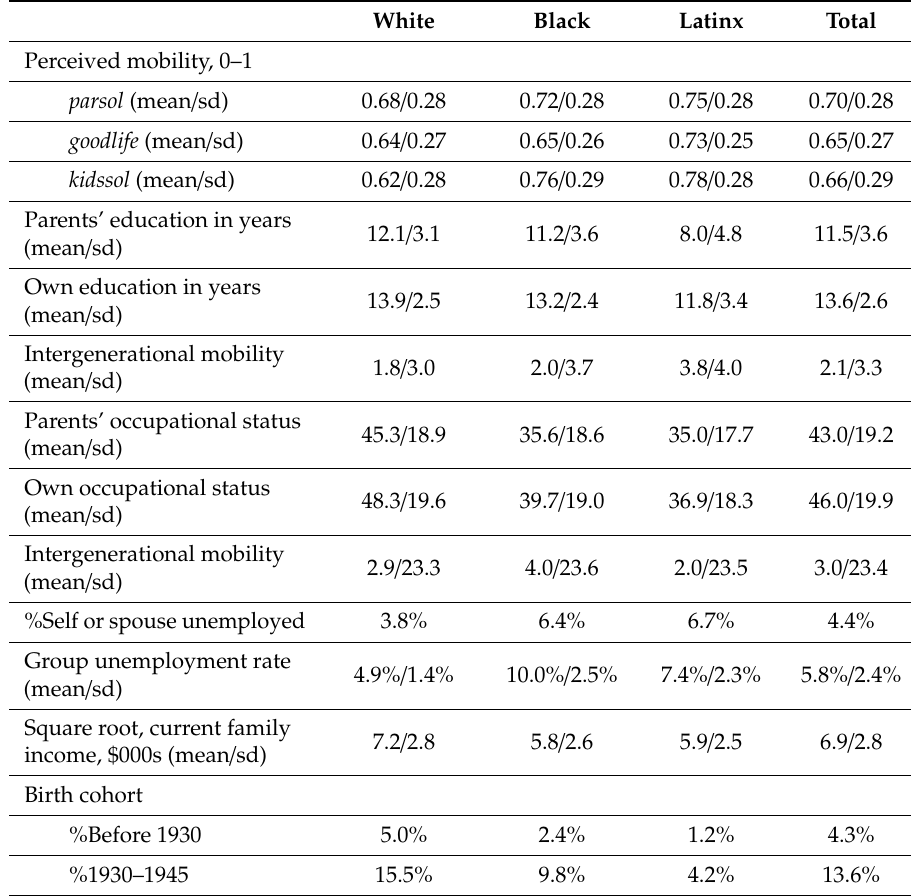
Table 1. Descriptive